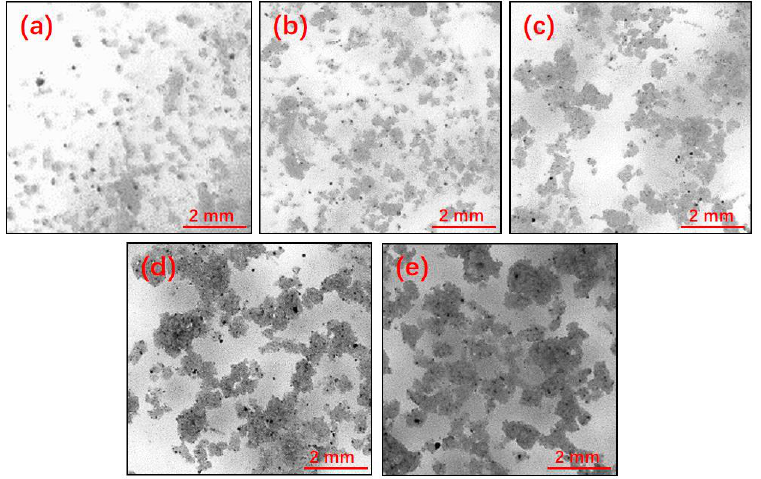
Figure 5. Stereomicroscopy images of kaolinite flocculation morphology at different PEO concen- trations: ( a ) 0.4 g/L; ( b ) 0.6 g/L; ( c ) 0.8 g/L; ( d ) 1 g/L; ( e ) 1.2 g/L.